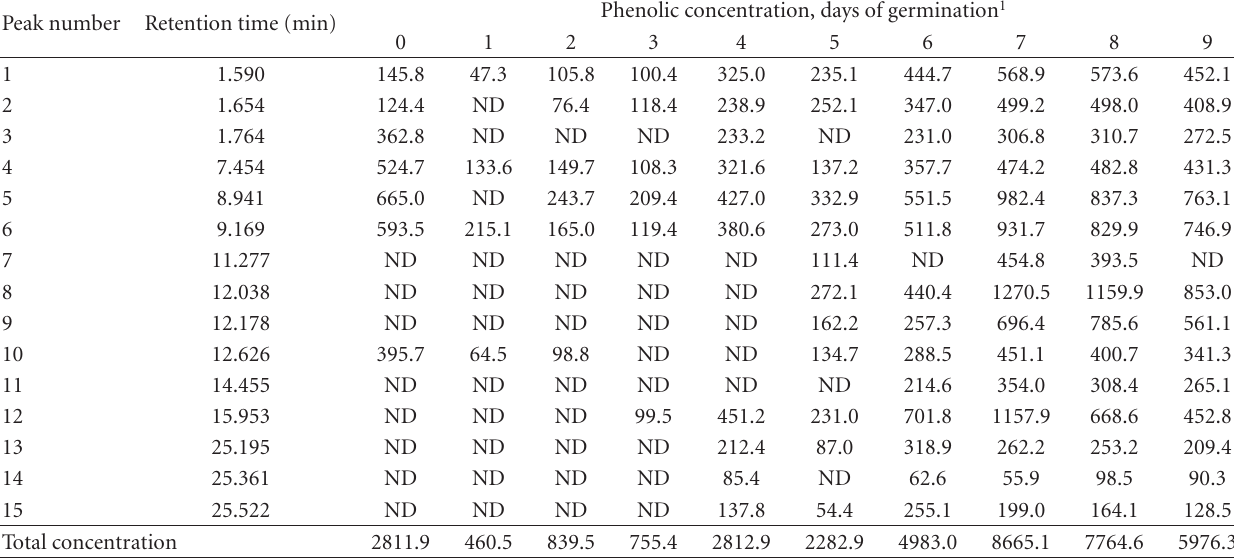
Table 2: Phenolic compounds in L. campestris germinated seeds by